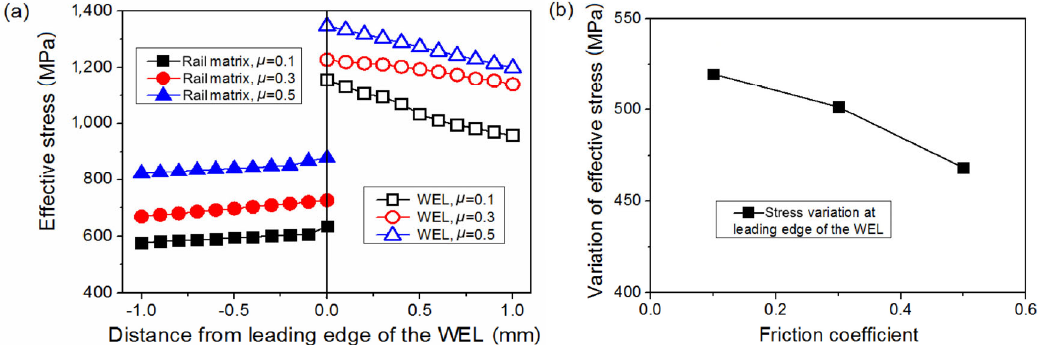
Fig. 8 (a) Distribution of effective stress around leading edge of the WEL under different friction coefficients and (b) variation of effective stress between the WEL and rail matrix as a function of μ